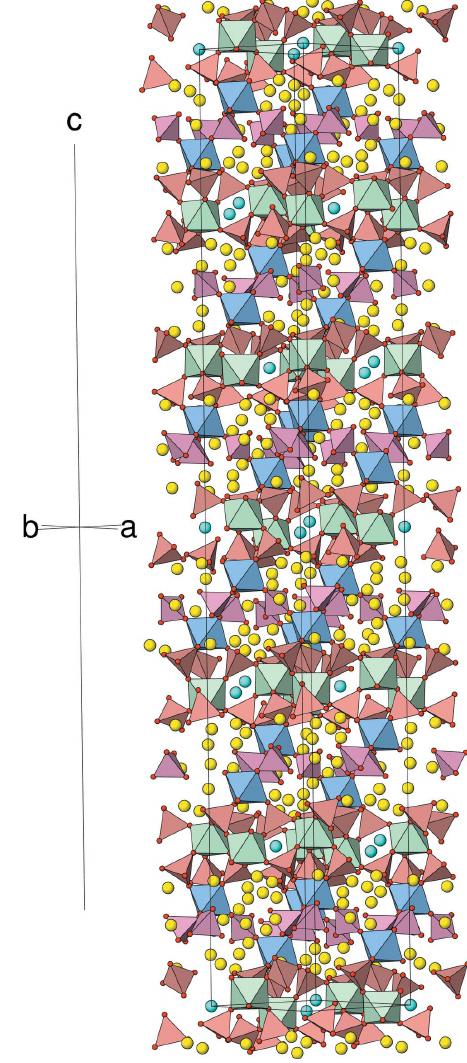
Figure 2 The unit-cell of (I) in polyhedral representation viewed approximately down [110]. A single O atom at the average location of O6 A and O6 B in the asymmetric unit has been used to construct the As2 tetrahedron. Colour code: Zr1O 6 octahedra blue, Zr2O 6 octahedra green, As1O 4 (cid:2) x , 2 (cid:2) x + y , 1 (cid:2) z ; tetrahedra peach, As2O 4 tetrahedra rose, Cs sky blue, Na yellow, O 3 3 6 (polyhedral corners)